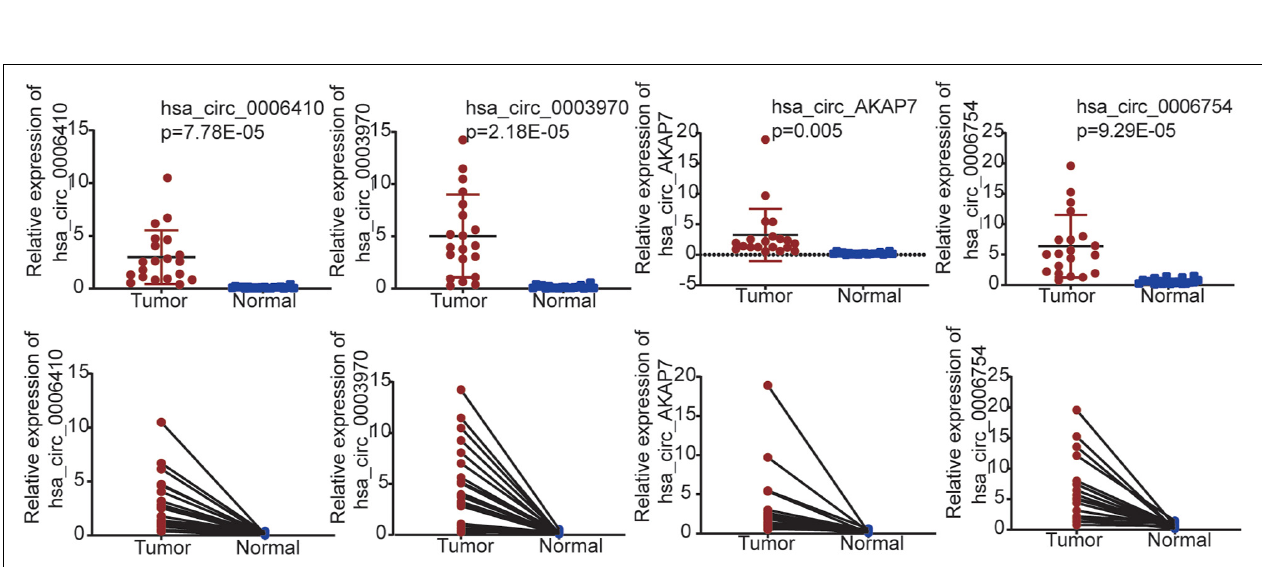
FIGURE 6 | qRT-PCR validation for PCa tissues and adjacent normal tissues in 20 samples from patient samples diagnosed with PCa. Only four circRNAs were significantly